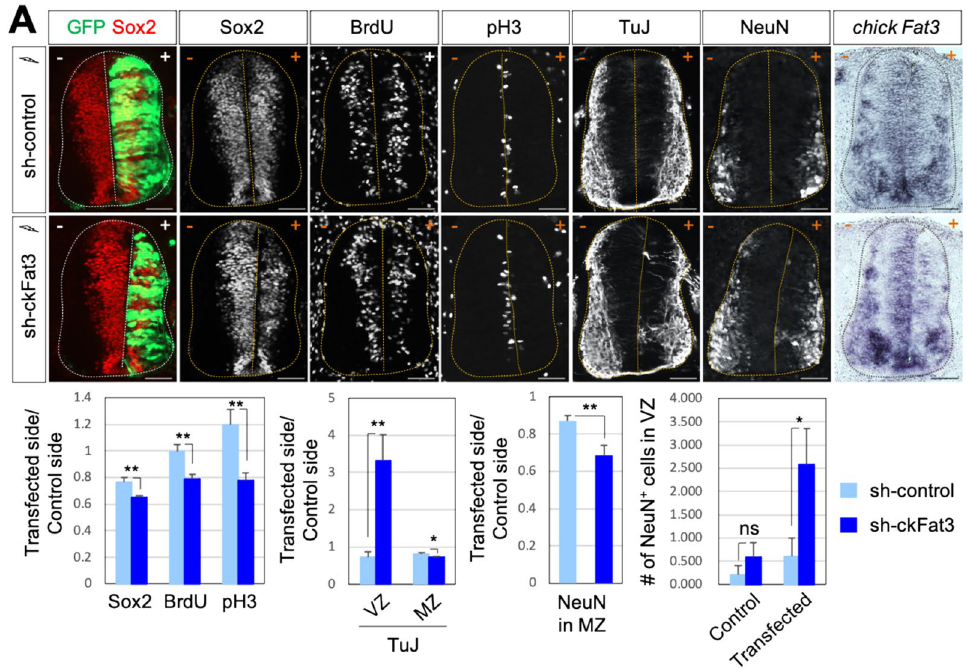
Figure 2. Fat3 is required for proliferation and maintenance of neural stem cell population. ( A ) In ovo electroporation of sh-control or sh-Fat3 was performed at HH13, followed by immunostaining analyses with indicated antibodies for chick embryos (thoracic level). GFP expression indicates transfected cells. Reduction of Fat3 expression by sh-Fat3 knockdown was confirmed by chick Fat3 ISH. Quantification of Sox2 + , BrdU + , pH3 + , TuJ + or NeuN + cells in the electroporated side (+) relative to those in the unelectroporated control side (−). Quantification was performed with 15–20 images from 5 to 7 embryos injected with each knockdown construct. Values are means ± sem. *p < 0.05, **p < 0.01 (Student’s t -test).; ns not significant. Dotted outlines indicate the border of the spinal cord. Scale bars: 100